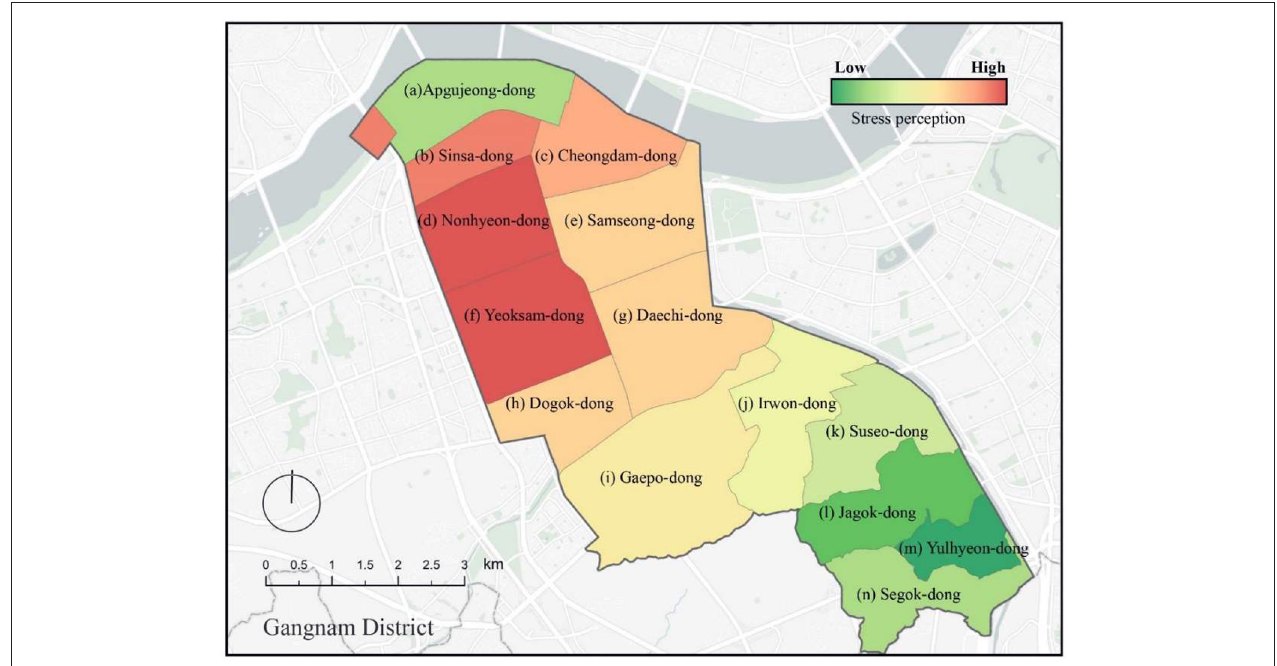
FIGURE 9 | Urban spatial mapping of perceived stress for Gangnam administrative divisions.